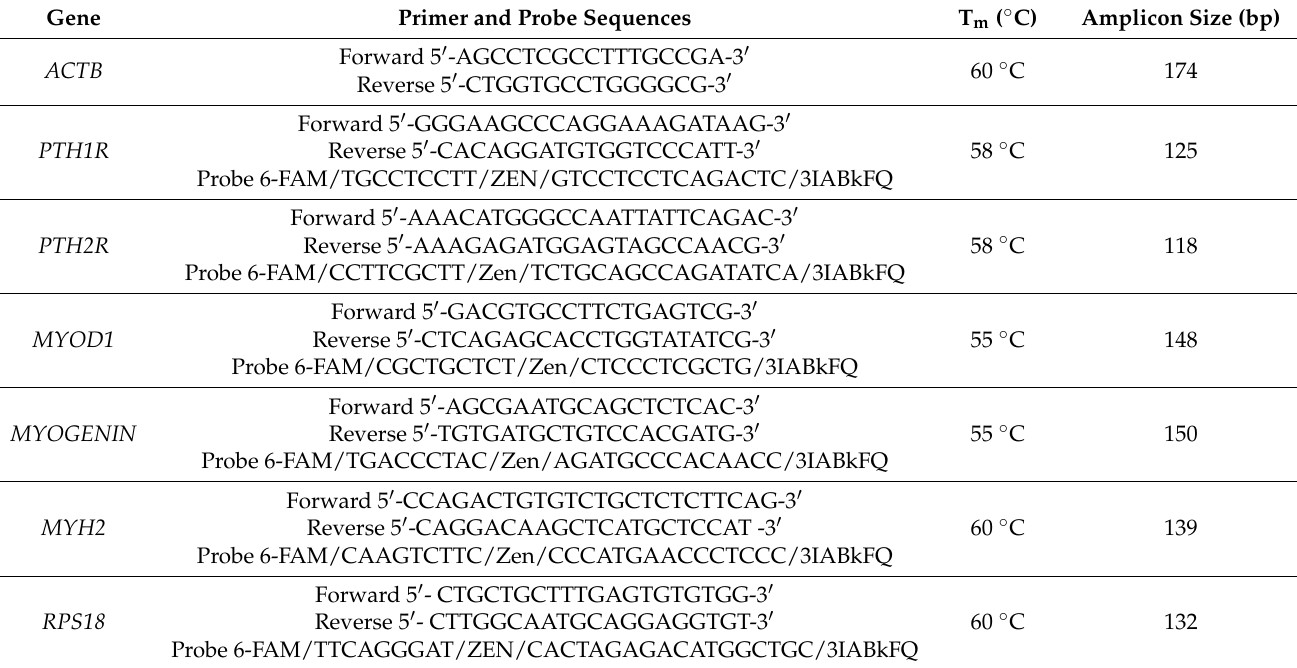
Table 1. List of the human gene specific primers and/or specific TaqMan probes used in the analysis. Gene Primer and Probe